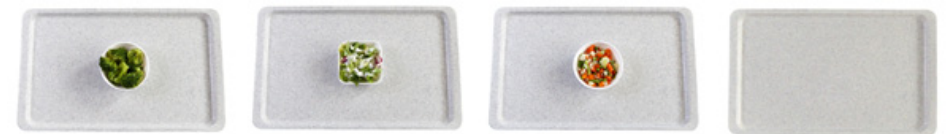
Figure 3. Example of the food choice scenario in the thin body shape nudge condition.